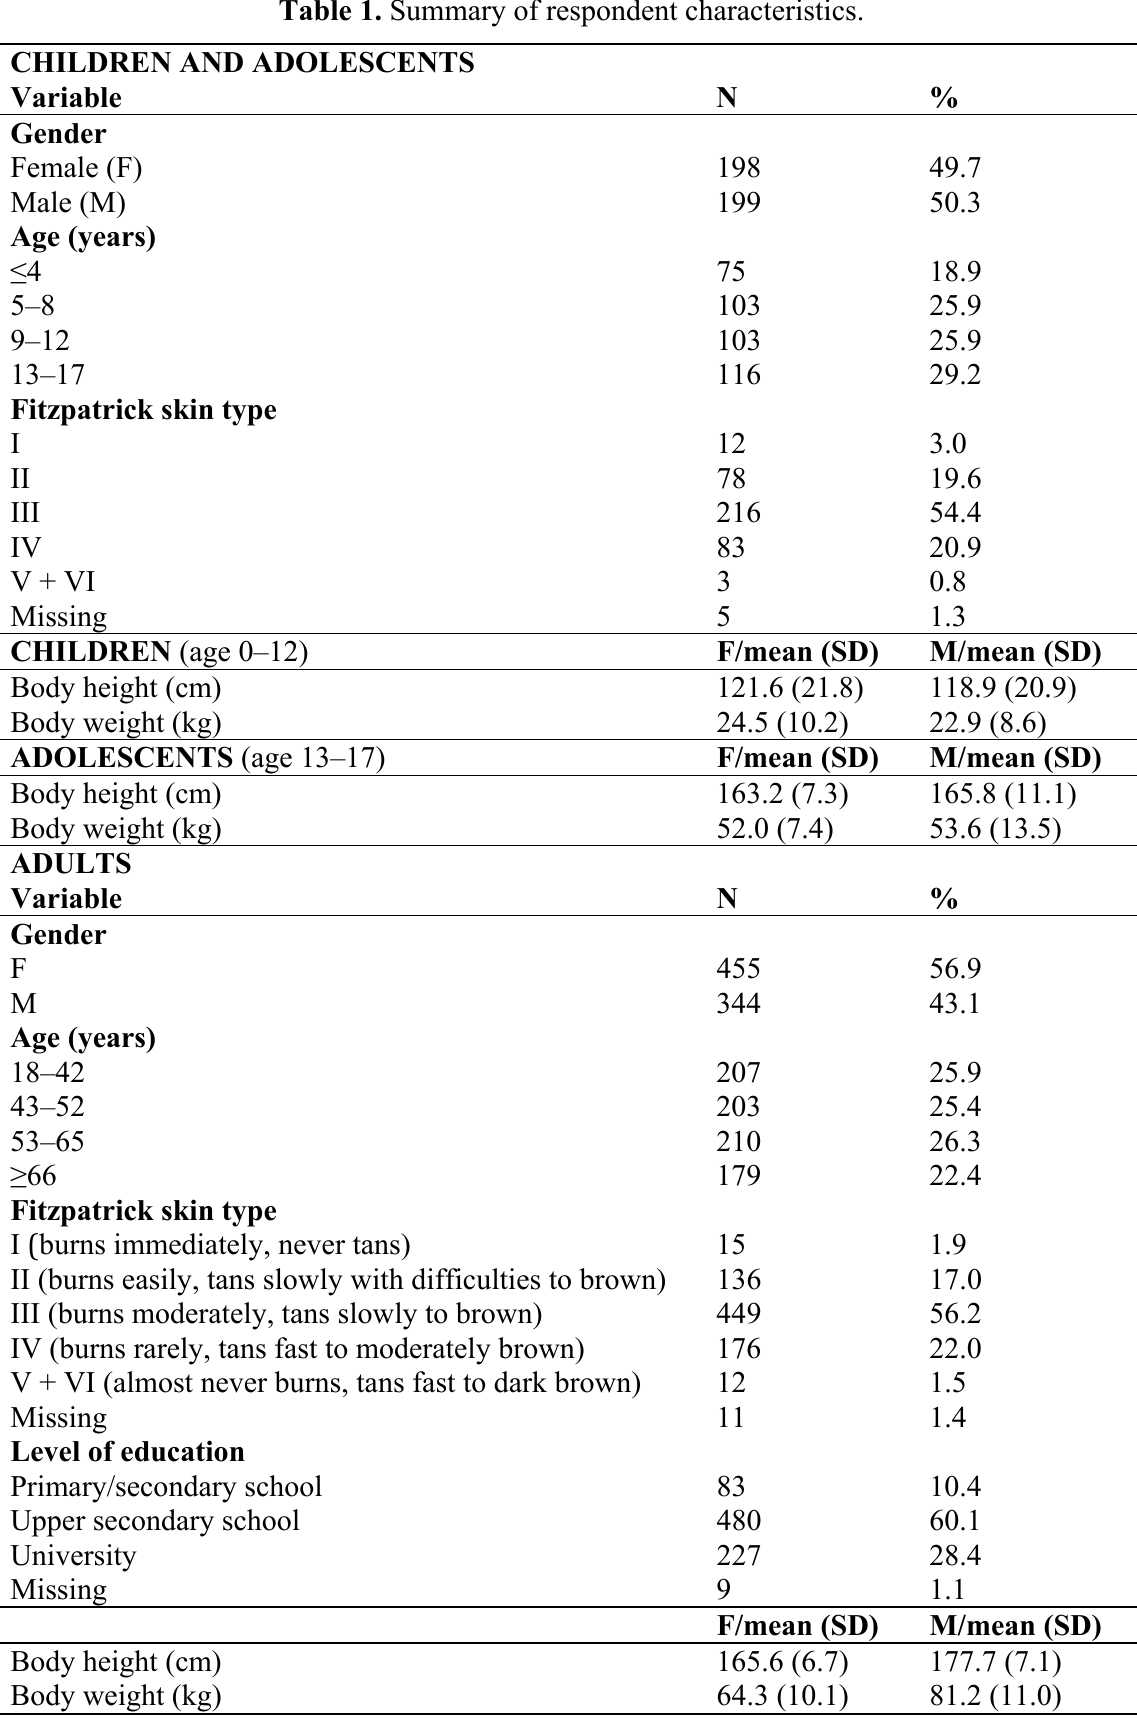
Table 1. Summary of respondent